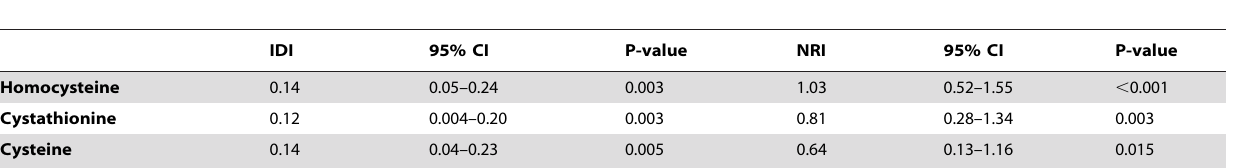
Table 6. The Integrated Discrimination Improvement (IDI) and Net Reclassification Improvement (NRI) were summarized below, supporting the statistical significance of the